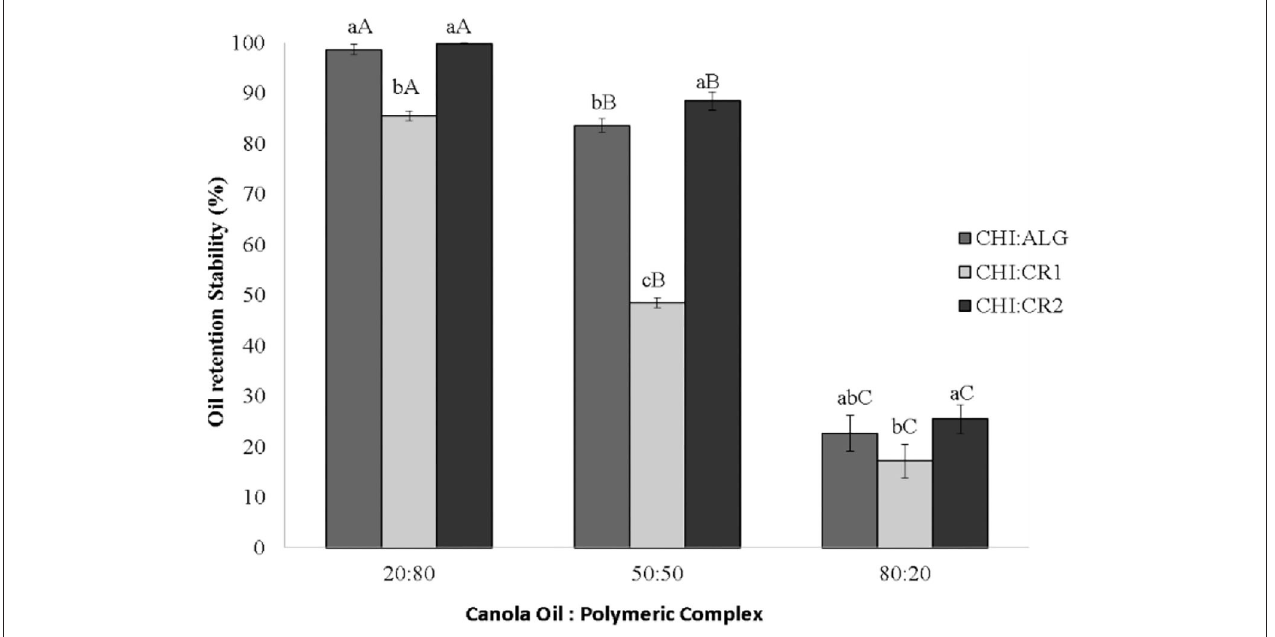
FIGURE 5 | Oil retention of polysaccharides complexes (CHI:ALG, CHI:CR1, and CHI:CR2) at three different percentages of canola oil (80, 50, and 20%) in the formulation. Different uppercase letters indicate a significant difference (p 0.05) in the same formulation at different oil ratio. Different lowercase letters indicate a ≤ significant difference (p 0.05) in the same oil ratio in different formulations. ≤